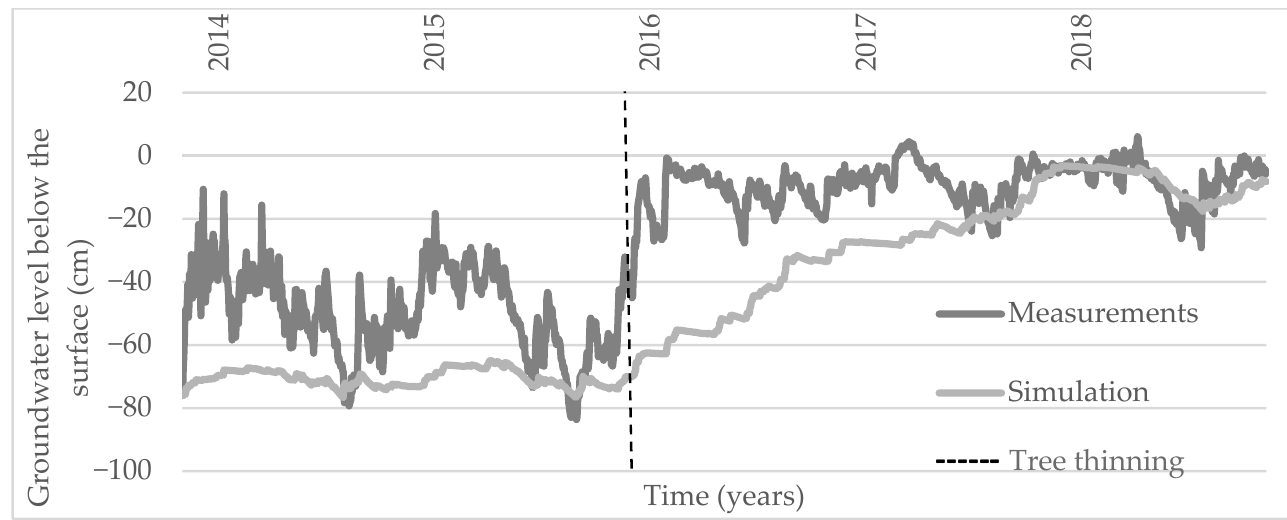
Figure 7. Measured vs. simulated groundwater level in plot 4.